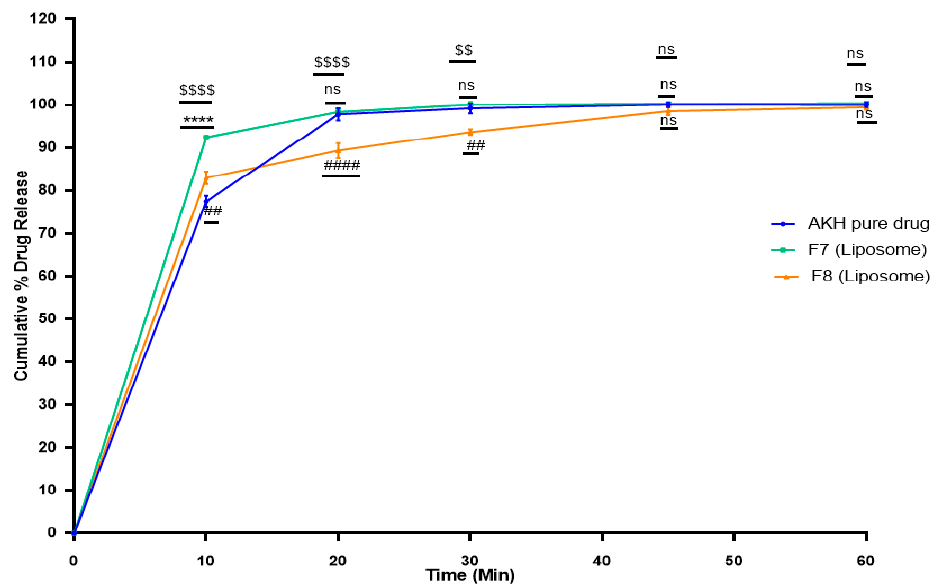
F7 (liposome) vs F8 (liposome) was determined using a 2-way ANOVA (Tukey’s multiple comparison test) in GraphPad Prism (viewing mode) 9.1.2 (226).